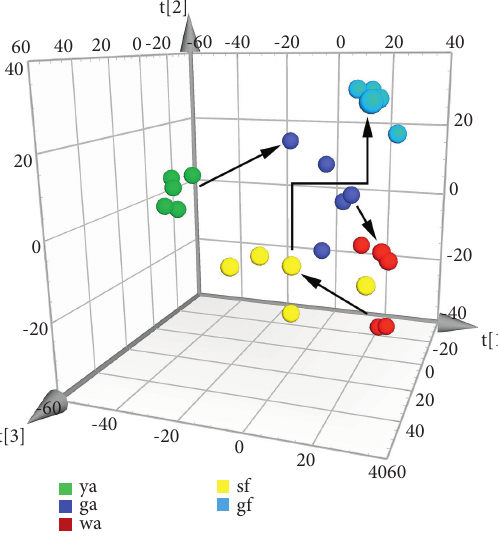
Figure 4: PCA scatter plot with UV